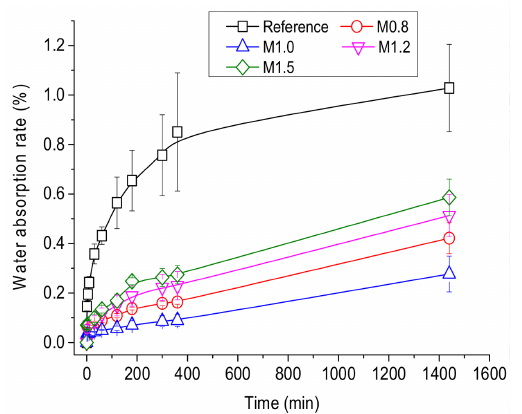
Figure 14. Water uptake of concrete sample sealed with the geopolymer coating.